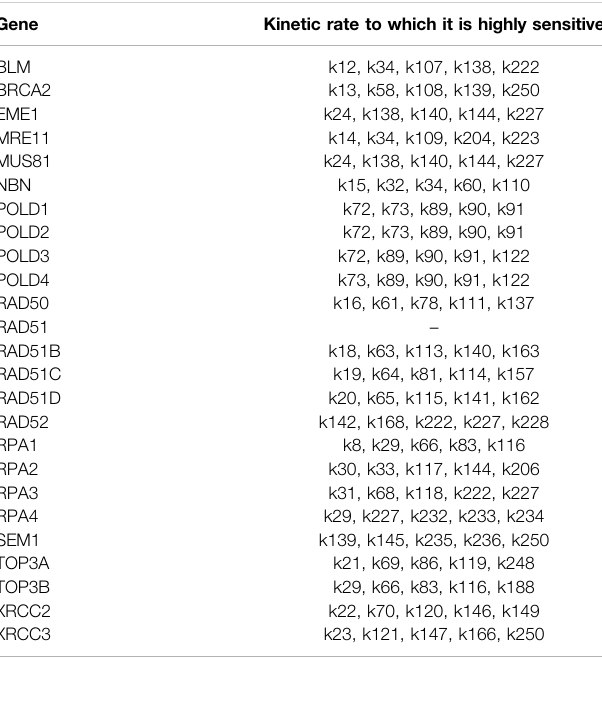
TABLE 7 | For each gene/protein in the HR pathway in (Orlic-Milacic, 2015) we selected the kinetic rates whose sensitivity index belongs to the 98th percentileofthesensitivityindexdistribution.Thesensitityindexiscalculatedusing the formula (1) .